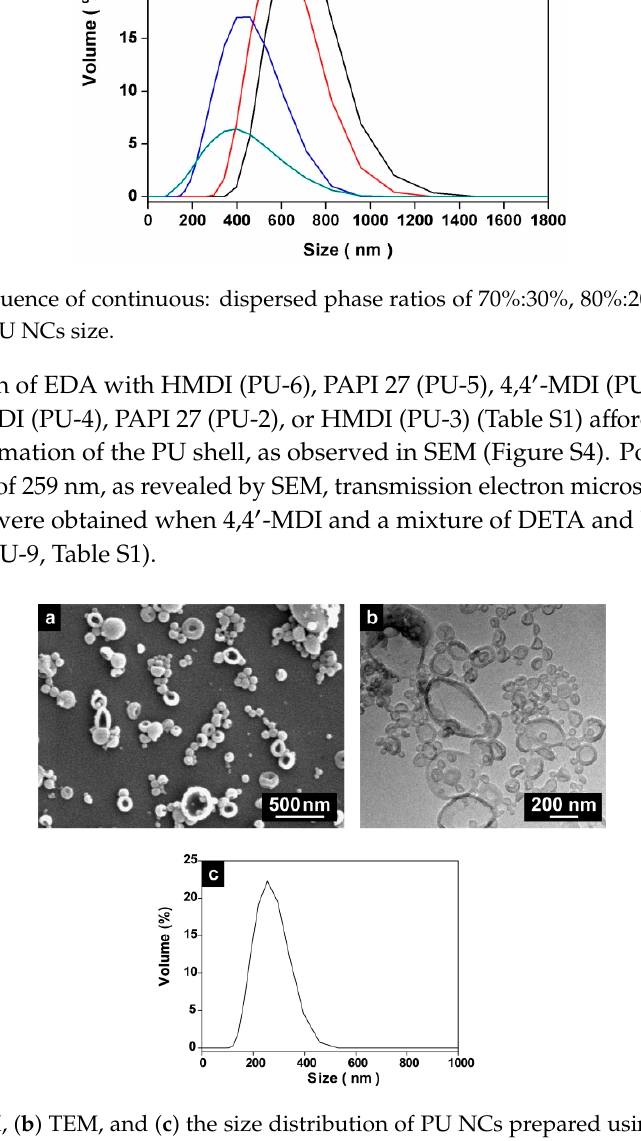
Figure 3. SEM images of PU NCs prepared using different continuous: aqueous phase ratios: ( a )